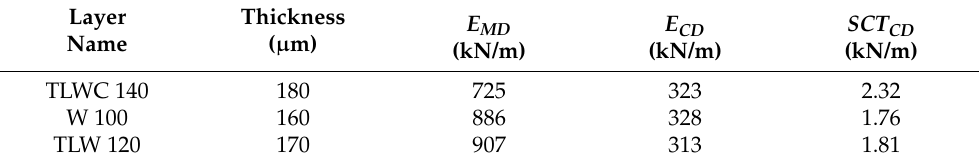
Table 2. Mechanical properties of individual layers of 5EB650C3.